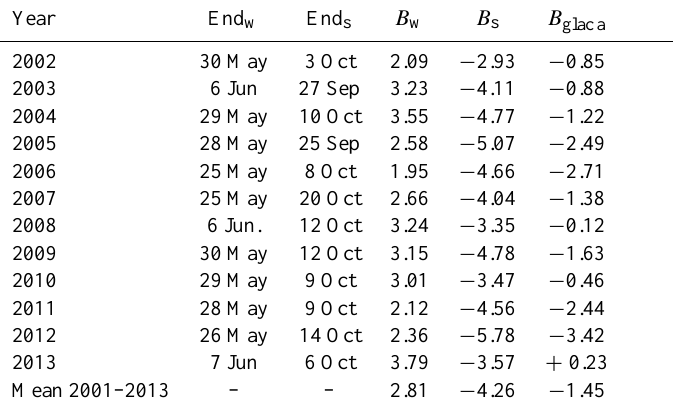
Table 3. Ossoue Glacier mass balance time series measured by glaciological methods (in mw . e . ). End w and End s refer to the end of winter and the end of summer, respectively, in the floating-date system (Cogley et al., 2011). B glaca means annual glaciological mass balance, B w refers to the winter mass balance, and B s refers to the summer mass balance.